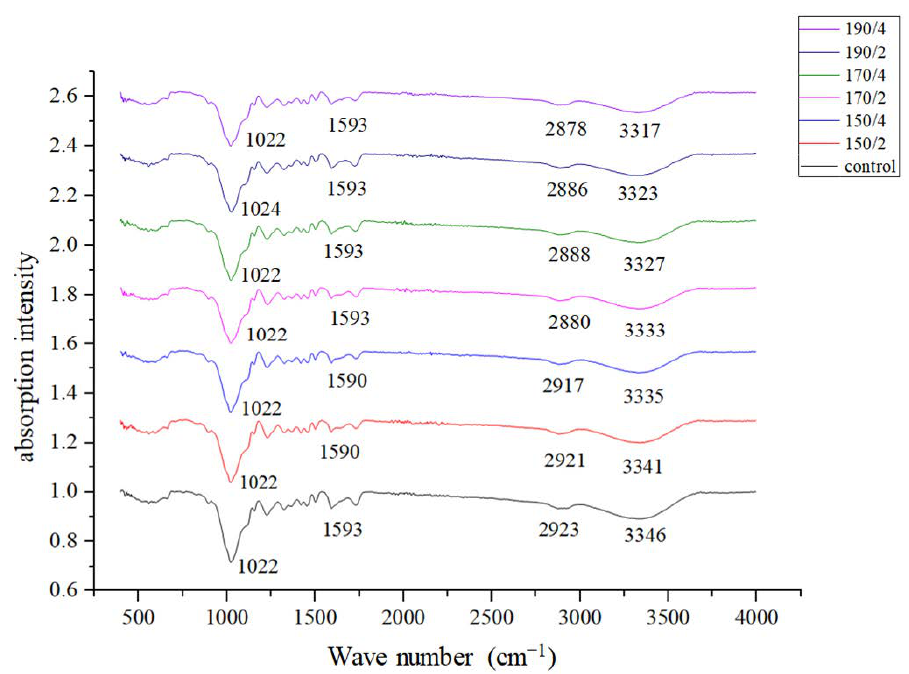
Figure 8. Infrared spectra of the control and heat-treated